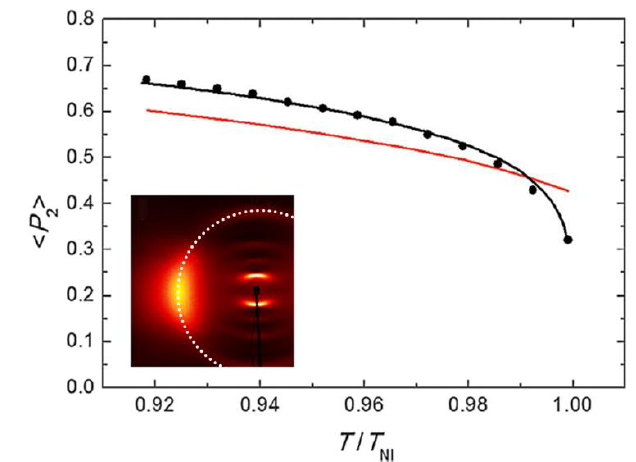
Figure 17. Orientational order parameter < P 2 > dependence on the reduced temperature T / T NI : experimental values (black dots) fitted by the Haller equation (black line) and compared to the Maier–Saupe (MS) theoretical prediction (red line). < P 2 > values were obtained by analyzing the azimuthal intensity profile of the wide-angle reflection measured along the dotted line shown in the inset. Adapted from [59] with permission from The Royal Society of Chemistry.